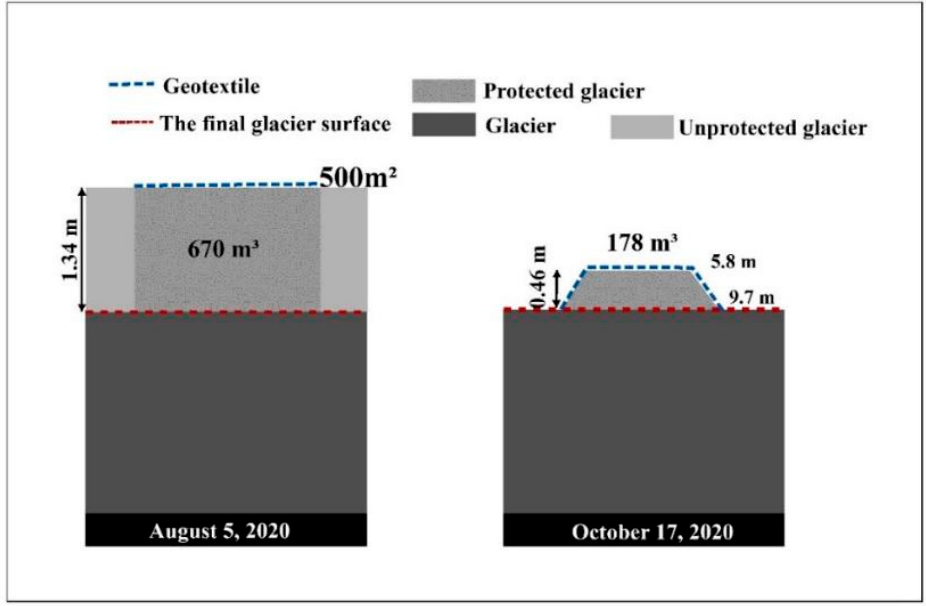
Figure 5. The schematic diagram for the protective effect of non ‐ woven geotextile on DG17 between